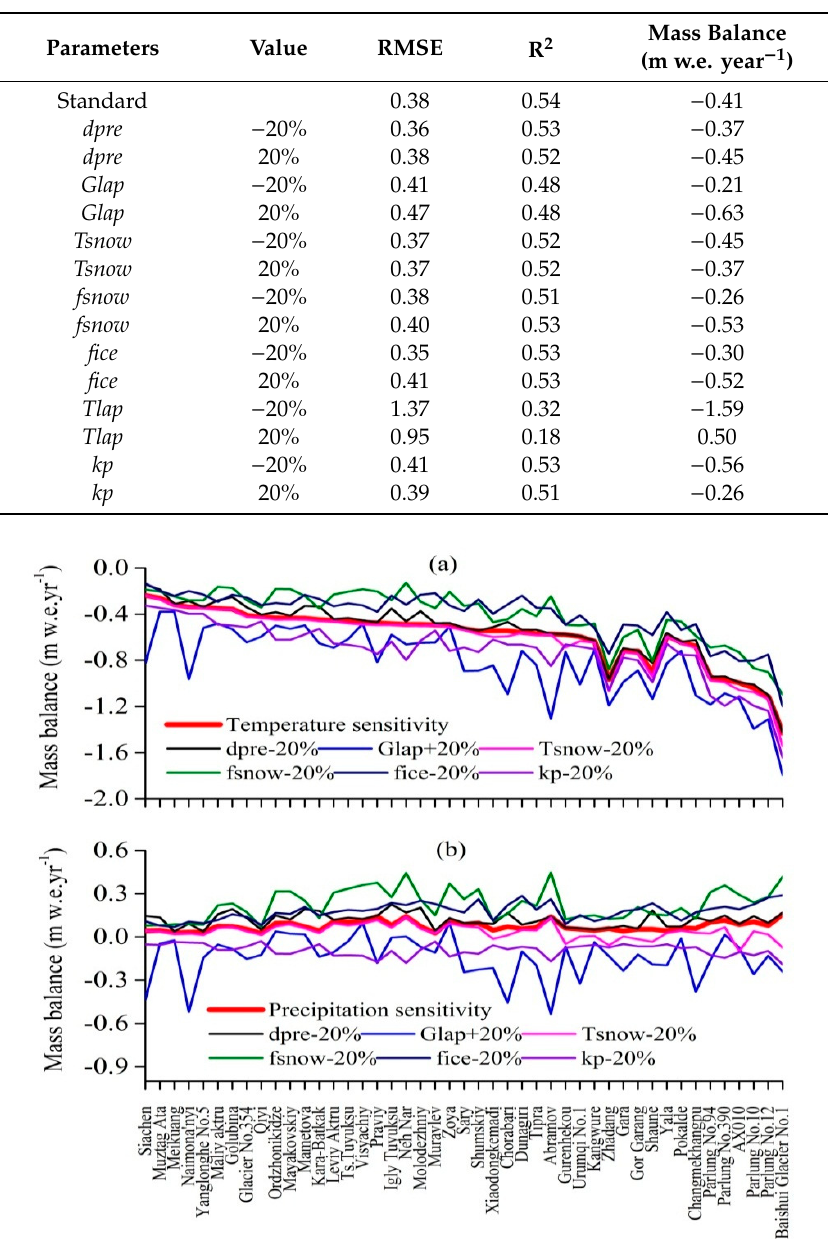
Table 2. Model sensitivity to parameter perturbations calculated as RMSE, R 2 and bias between the observed and modeled (parameter-perturbed) mass balance time series averaged across the 45 glaciers. The standard run is the simulation using all the initial (optimized) parameter values.